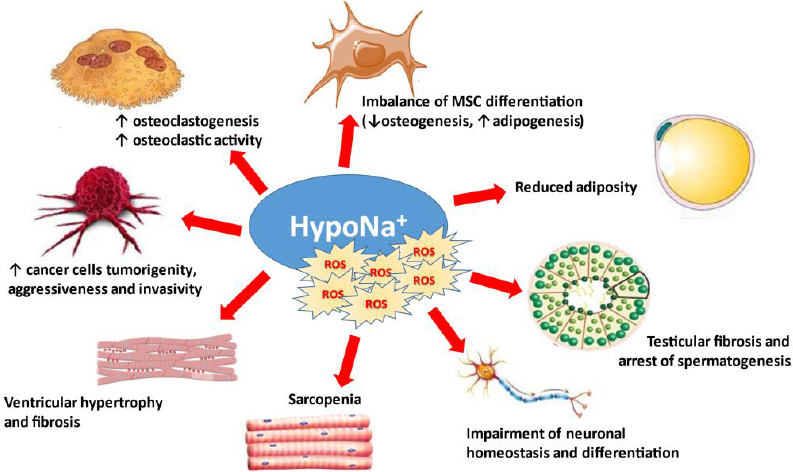
Figure 3. Osmotically-independent effects of hyponatremia and oxidative stress. MSC: mesenchymal stromal cells.